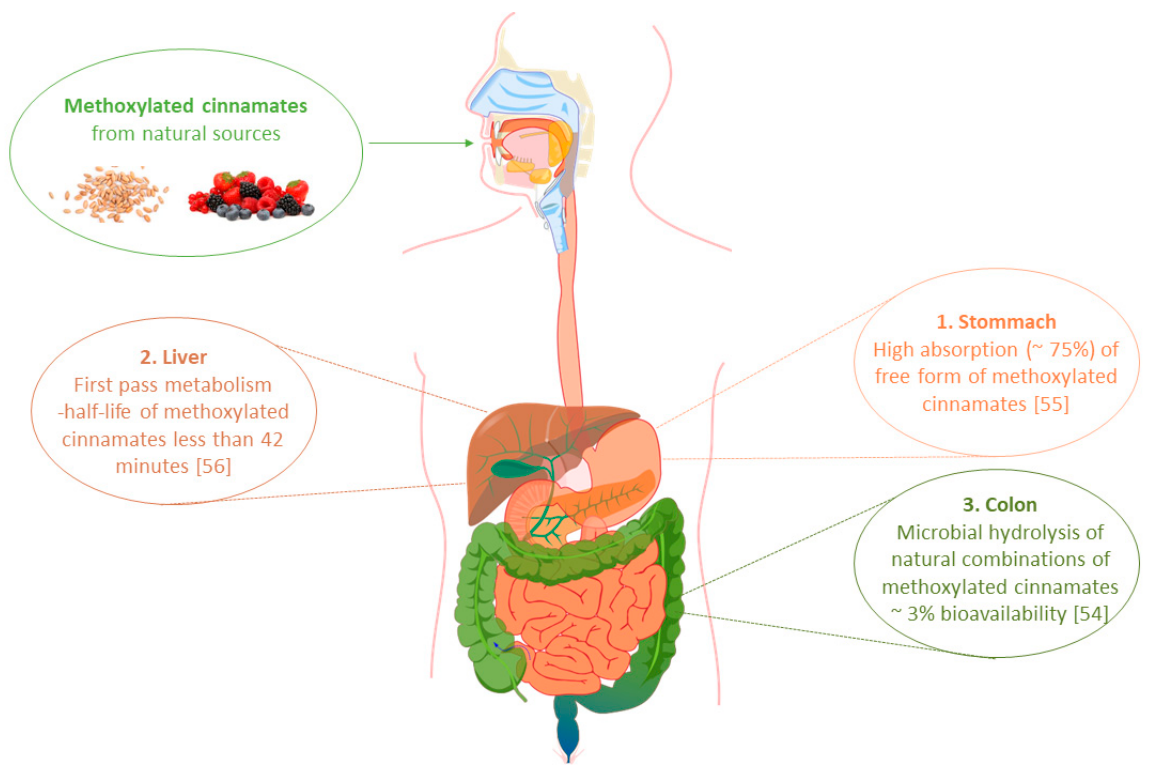
Figure 2. Absorption of dietary methoxylated derivatives of phenylpropenoic acids in the human gastrointestinal tract.